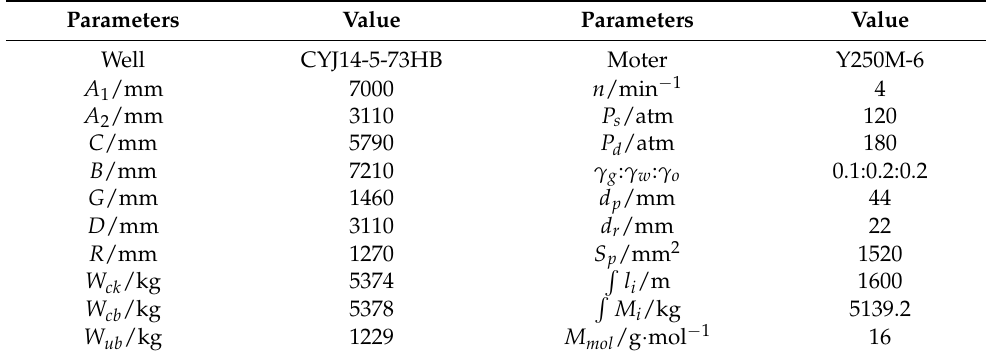
Table 2. The main parameters of the test well.